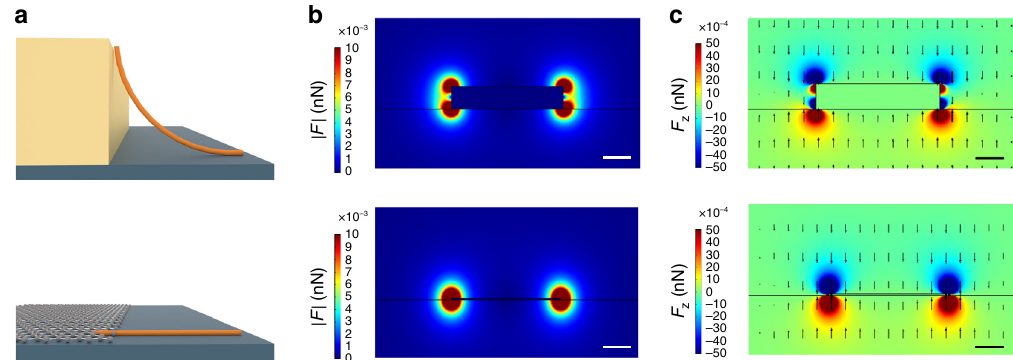
Fig. 2 Geometrical and electrostatic conditions in graphene-based placement of nanomaterials. a Cross-section of a standard metal electrode used for electric- fi eld-assisted assembly of nanomaterials and a graphene layer, having a thickness of 1.5 nm in our experiments, which is used for the same purpose. Both electrodes are located on top of a solid substrate. As a reference placement example, a carbon nanotube is shown that bridges contact and substrate. Cross-section of the b dielectrophoresis force distribution and c dielectrophoresis force z -component exerted on a carbon nanotube in aqueous solution which is generated by a dc voltage applied to the standard metal electrode (top) and the graphene layer (bottom), respectively. Scale bar: 50 nm